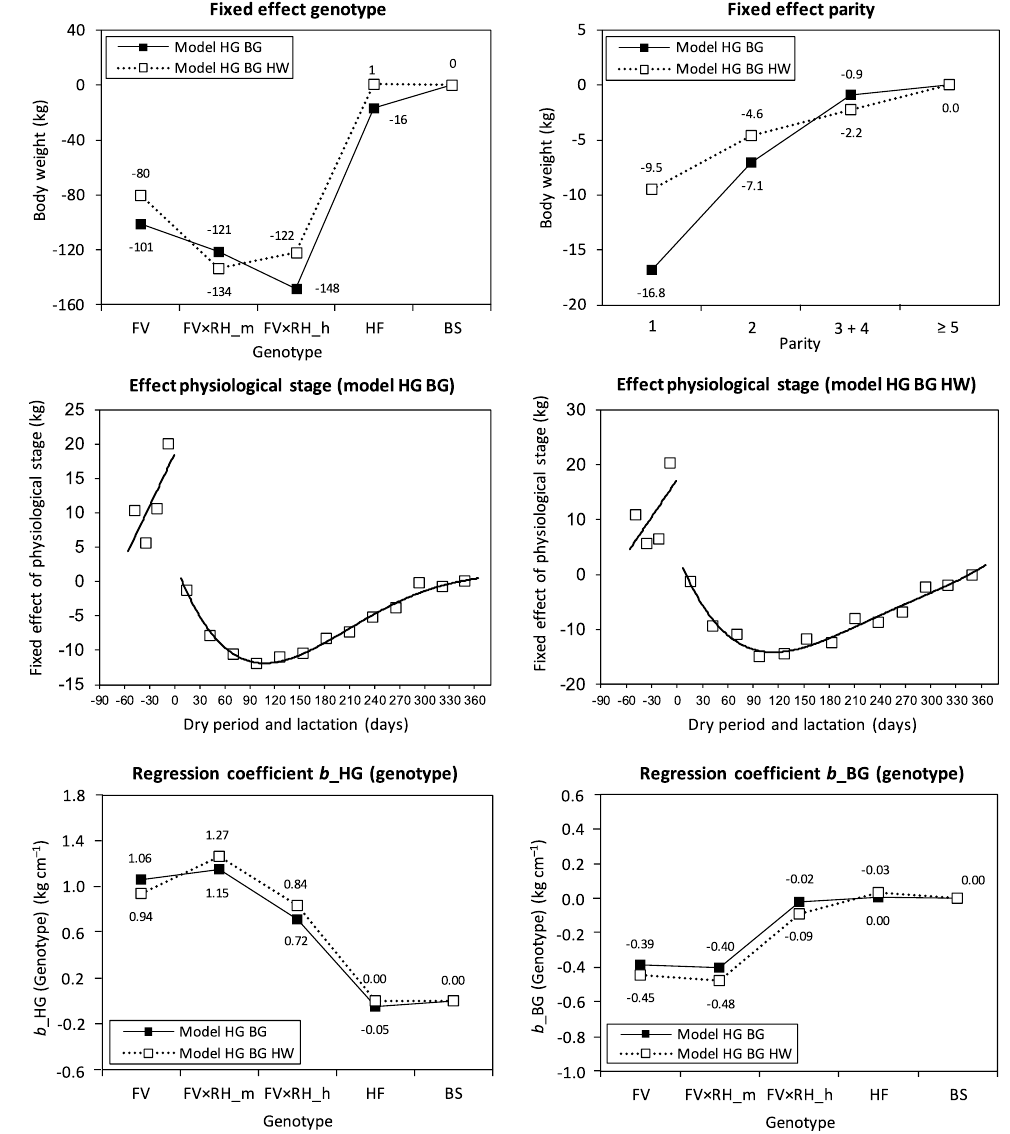
Figure 1. Fixed effect of genotype (FV: Fleckvieh; RH: Red Holstein (gene proportion); HF: Holstein Friesian; BS: Brown Swiss; m: medium; h: high), parity, the curves fitted on the fixed effect of physiological stage, as well as the genotype-specific regression coefficients ( b ) for heart girth (HG) and belly girth (BG) in the prediction equations Model HG BG and Model HG BG HW (HW: hip